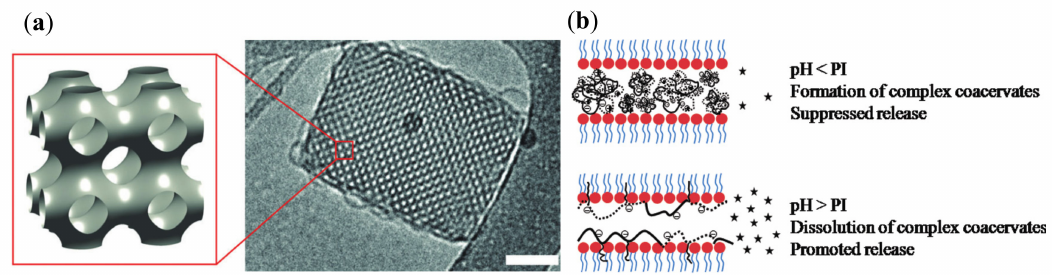
Figure 6. ( a ) Three-dimensional (3D) presentation of a primitive Im3m cubic lipid lattice and a cryo-TEM image of PP50 polymer-modified monoolein cubosome (reproduced from [77], with permission from the Royal Society of Chemistry, 2020). ( b ) Scheme of the drug release (stars) from the water channels of a monoolein cubic phase modified by polyelectrolytes (reproduced from [80], with permission from the American Chemical Society,